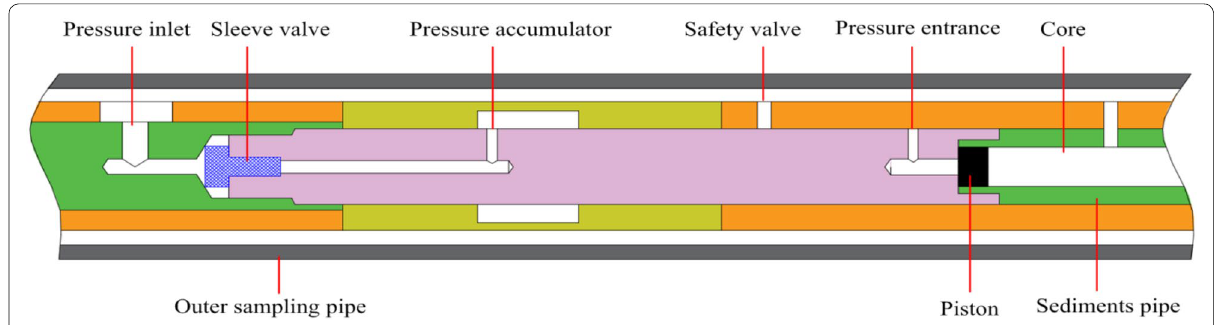
Figure 12 Schematic of PRT with internal